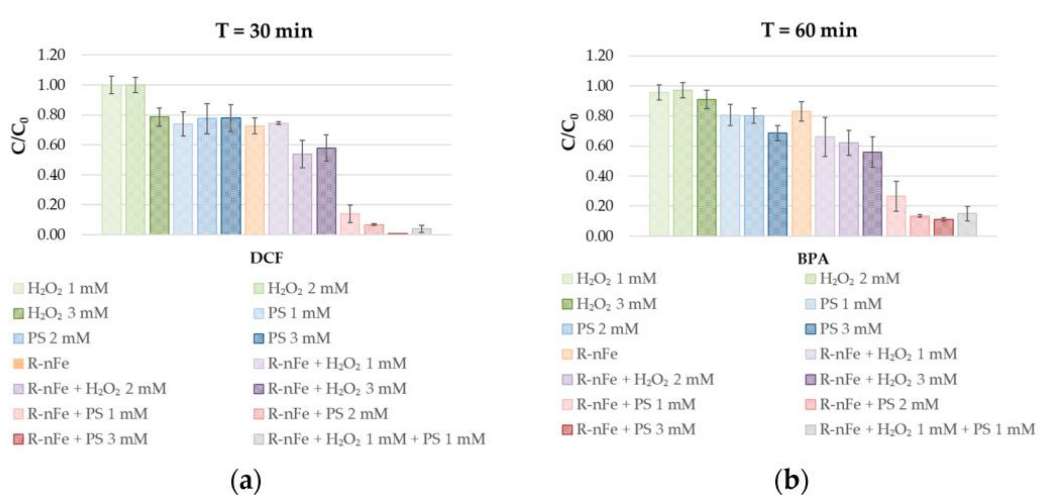
Figure 5. The removal efficiency of diclofenac at a contact time of 30 min ( a ) and bisphenol A at a contact time of 60 min ( b ) under different experimental conditions testing the effect of concentration of H 2 O 2 and PS, their synergy with R-nFe, and a coupling of H 2 O 2 with PS and R-nFe.